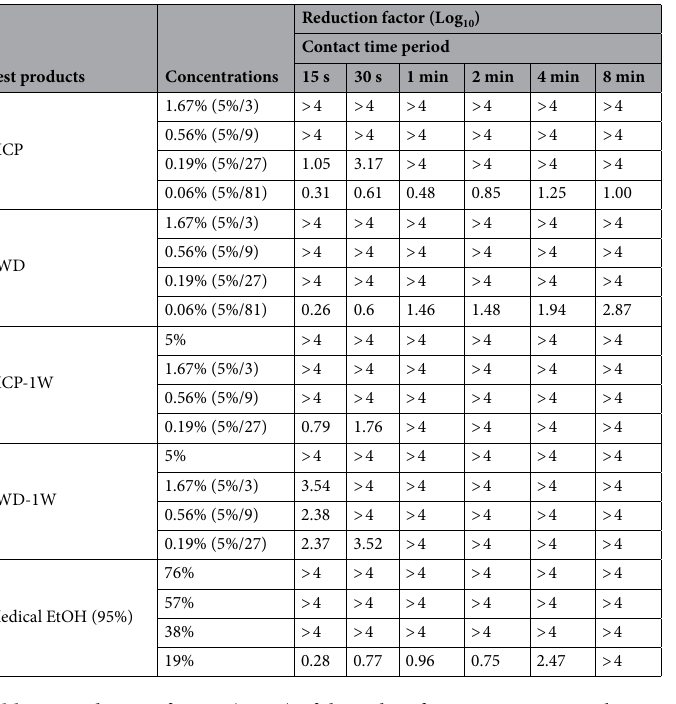
Table 2. Reduction factors (Log 10 ) of three disinfectants against Nipah virus. The virucidal efficacy of the three disinfectants against Nipah virus was addressed by quantitative suspension assay and residual infectivity was determined by virus titre using one-step real-time